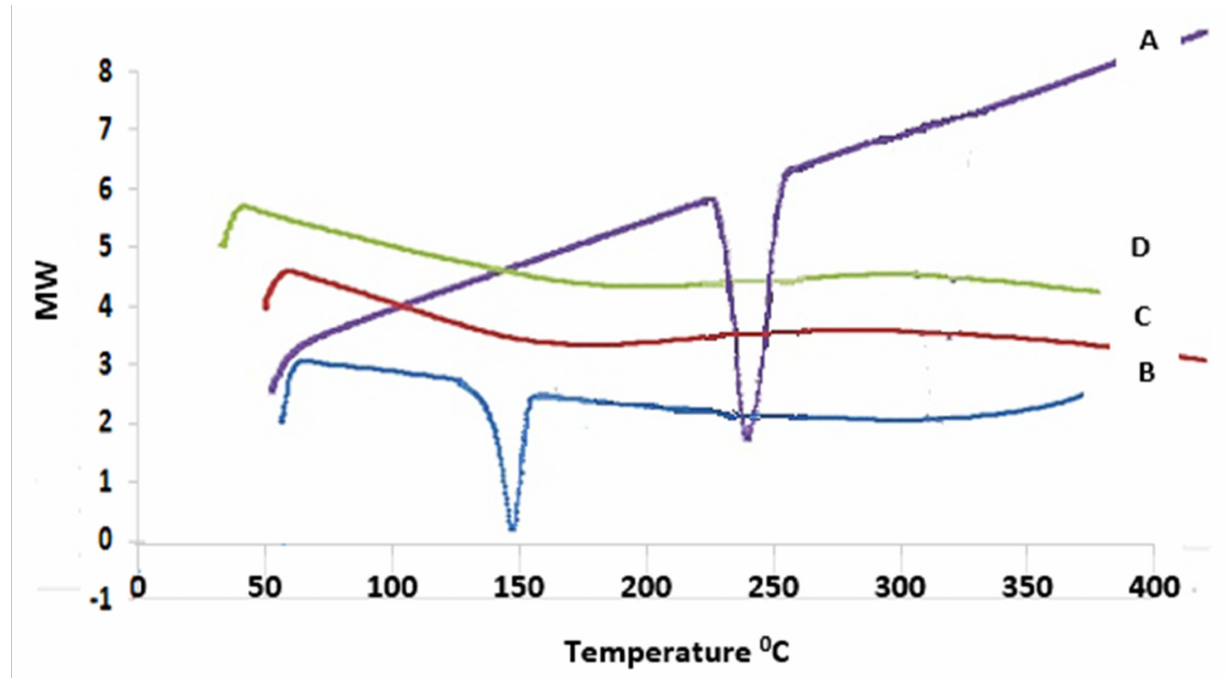
Figure 13. DSC thermograms: A: thermogram of pure 4e ; B: thermogram of cholesterol; C: thermogram of plain formula (F7); and D: thermogram of the optimum 4e -loaded PEGylated bilosome